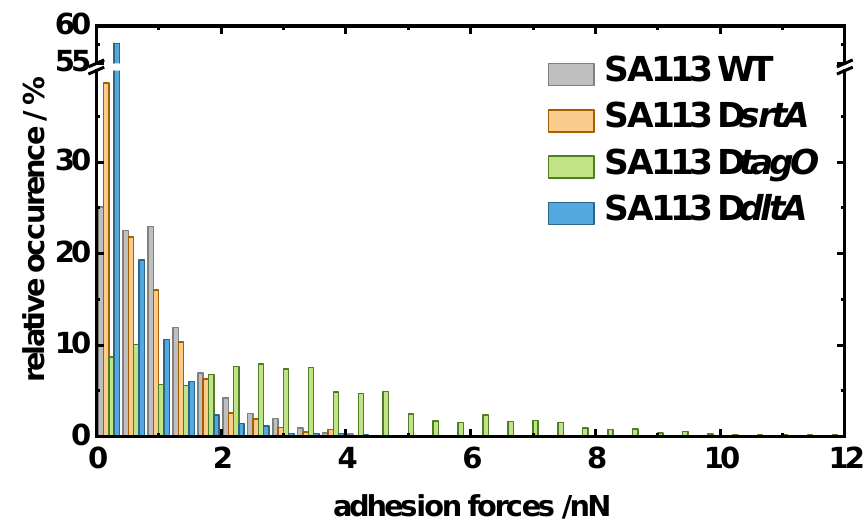
Figure A2. Overview histogram of all measured values of adhesion force of 11 single SA113 ∆ srtA , 15 single SA113 ∆ tagO , and 18 single SA113 ∆ dltA cells on hydrophilic surfaces. The corresponding values of an SA113 wild-type population are shown in gray